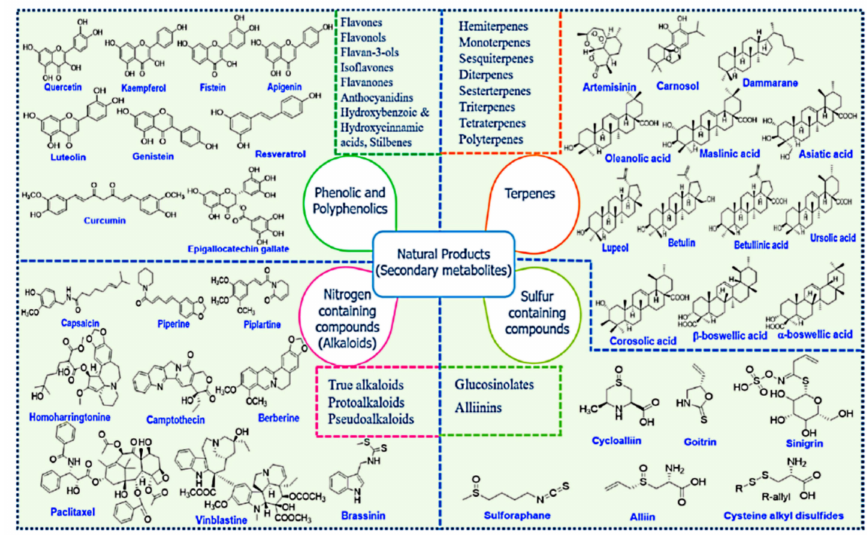
Figure 20. Chemical structures of various classes of natural compounds (prodrugs). Reproduced with permission from [285], Elsevier Ltd.,